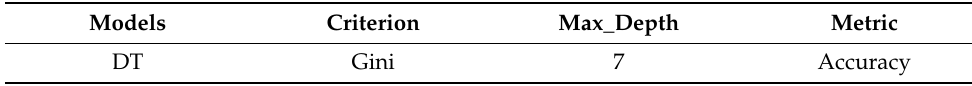
Table 4. The used configuration parameters for ANN, ES-LSTM, and RNN models.